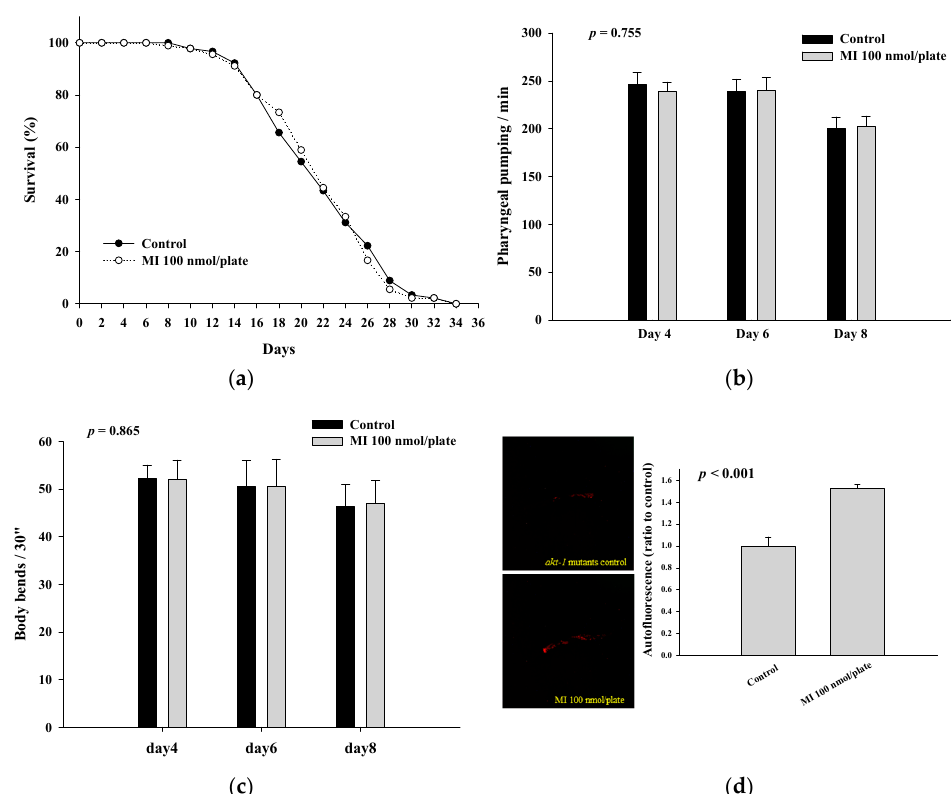
Figure 3. Effects of the myo-inositol (MI) on the lifespan and health of the AKT-1 mutants. ( a ) For the lifespan assay, various mutants (90 worms per group) were grown on plates containing with or without 100 nmol/plate of MI. The surviving worms were counted every two days. The surviving percentages were obtained, and the results were analyzed by the log-rank test with the SPSS software. For the health analysis, the nematodes were grown on plates containing with or without 100 nmol/plate of MI. ( b ) The pharyngeal pumping ( n = 10), ( c ) body bends ( n = 10), and ( d ) autofluorescence (left: photos; right: quantitative results, n = 3) were determined as described previously. Values are presented as mean ± SD, and p values are shown in the figures. The results are from a representative experiment out of three independent experiments. Table 2. Effect of myo-inositol (MI) on the lifespan of the